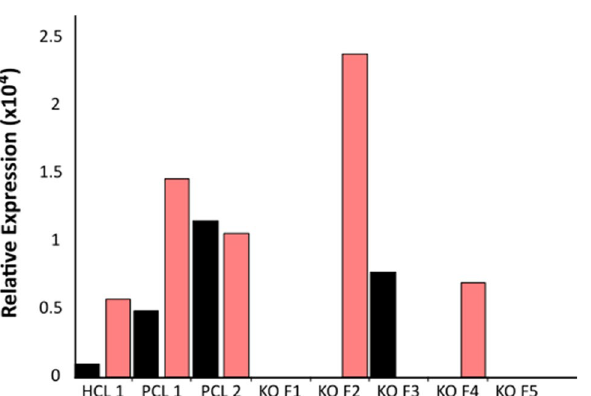
Figure 5. Histological analysis of a representative fetus harvested from embryo transfer (ET) 2 alongside horned and polled controls. ( a – c ) Fontal skin and ( d – f ) horn bud region of age matched horned and polled control fetuses alongside fetus 2, a representative biallelic lincRNA#1 knockout fetus from ET2, at 90 days of gestation. Multiple layers of vacuolated keratinocytes and nerve bundles (black stars) can be seen in the horn bud region of the horned control fetus, and hair follicles can be seen in the frontal skin of all fetuses as well as the horn bud regions of the polled control and the knockout fetus (yellow arrows).